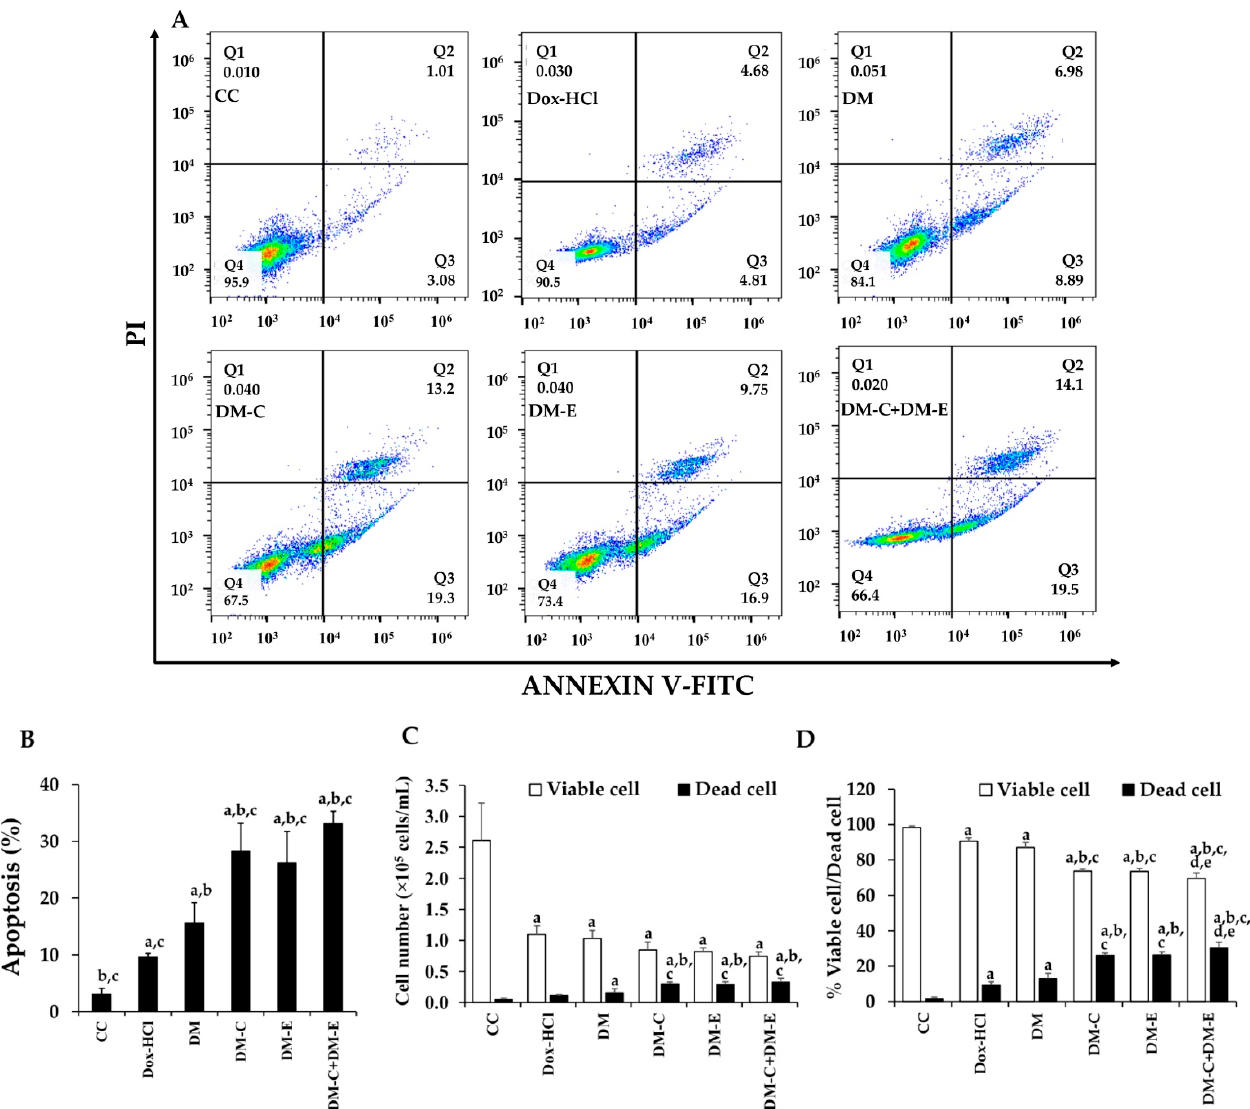
Figure 12. Following 48 h of incubation with media (CC), Dox-HCl, DM, DM-CKR (DM-C), DM-EVQ (DM-E), DM-CKR+DM-EVQ (DM-C+DM-E) at 37 °C, 5% CO 2 . ( A ) The apoptotic rate of KG-1a cells was determined using Annexin V and PI staining and flow cytometry. The quadrants Q1, Q2, Q3, and Q4 indicated necrotic cells, late apoptotic cells, early apoptotic cells, and intact cells, respectively. ( B ) The percentage of apoptotic cells (both early and late apoptosis) in cell control (CC), Dox-HCl, and different DM formulations. ( C ) The cell number and ( D ) the percentage of viable and dead cells of each sample were determined using the trypan blue exclusion method. The data were represented as mean ± SD ( n = 3). a p < 0.05 compared with CC, b p < 0.05 compared with Dox-HCl, c p < 0.05 compared with DM, d p < 0.05 compared with DM-C, and e p < 0.05 compared with DM-E.